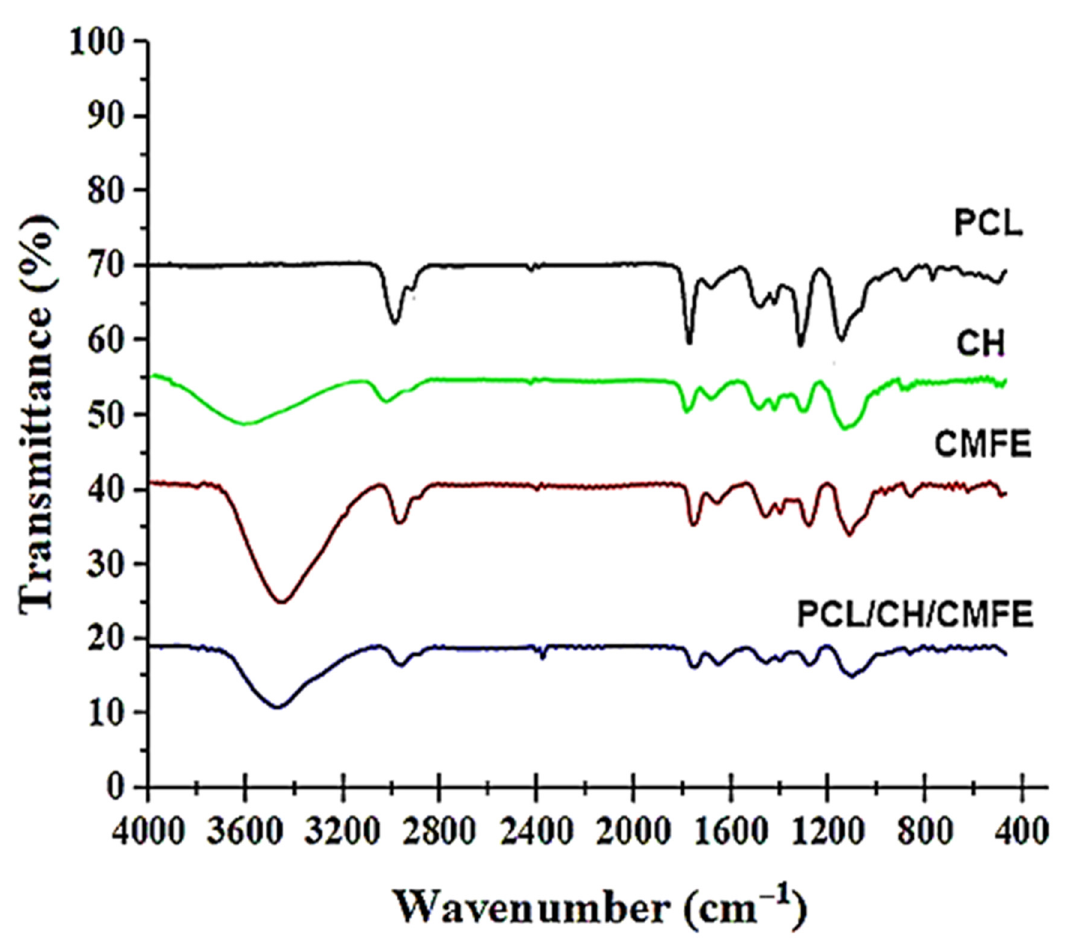
Figure 3. FTIR spectra of polycaprolactone (PCL), chitosan (CH). Cordia myxa fruit extract (CMFE), and PCL/CH/CMFE composite nanofibers.